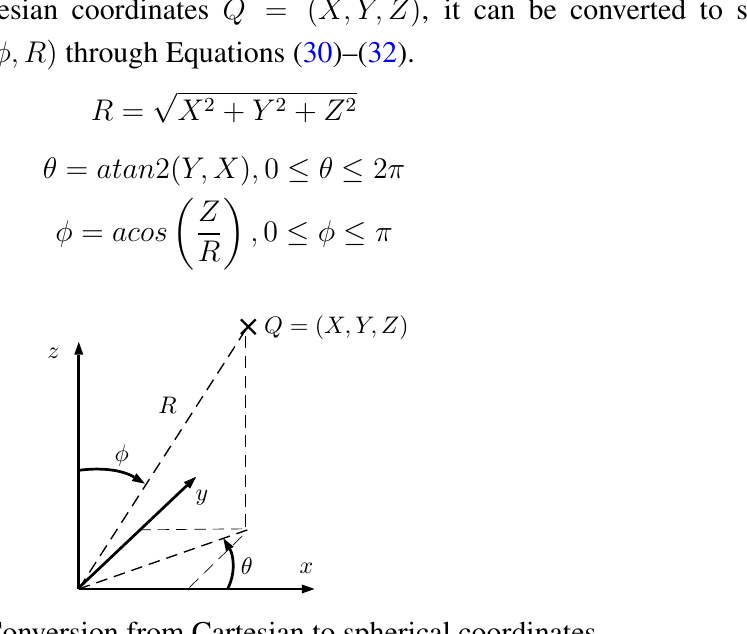
Figure 15. Conversion from Cartesian to spherical coordinates.